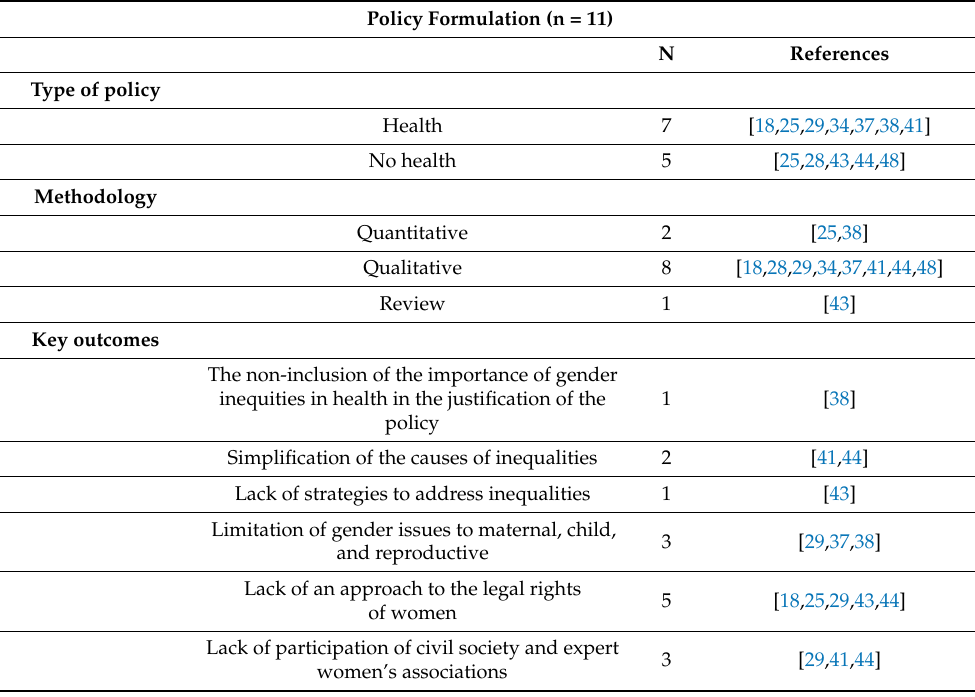
Table 1. Description of main characteristics and key outcomes of the 11 included papers analysing the formulation of policies aimed at reduce gender inequalities in health.